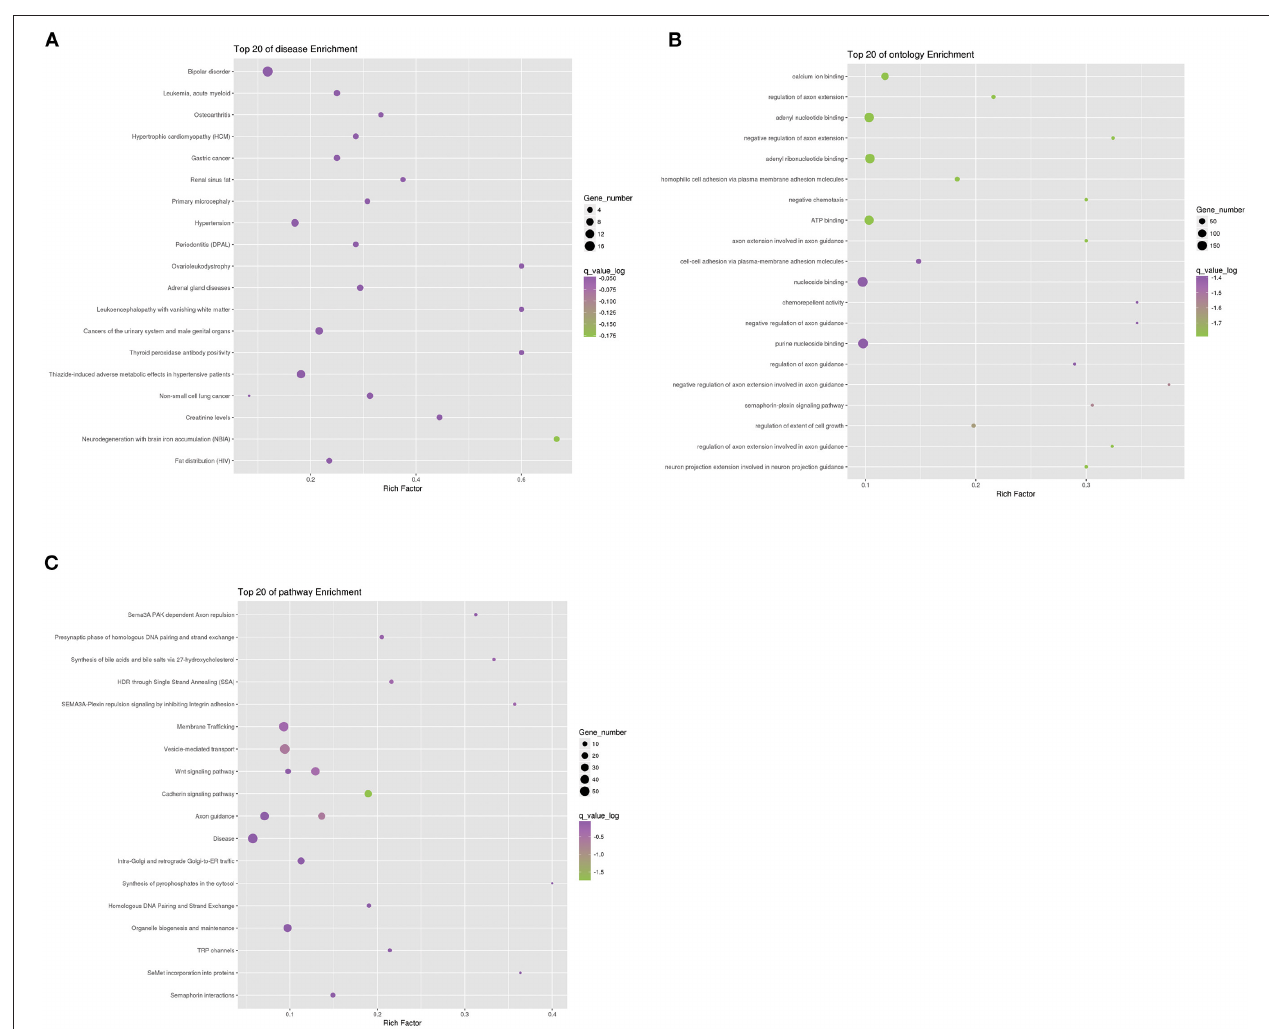
FIGURE 4 | Enrichment analysis of differential genes between PS-PA/IVS and control groups. Top 20 of disease (A) , ontology (B) , and pathway (C) enrichment were listed.